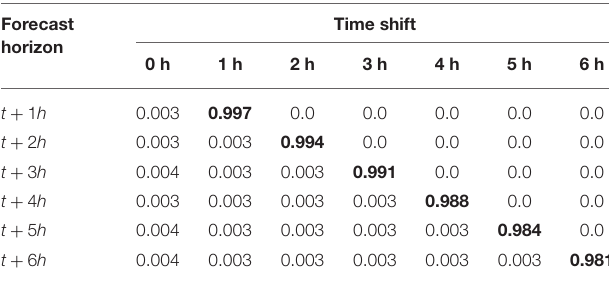
The algorithm detects that the persistence model is shifted with the expected number of hours. The largest values of each row are annotated in bold.